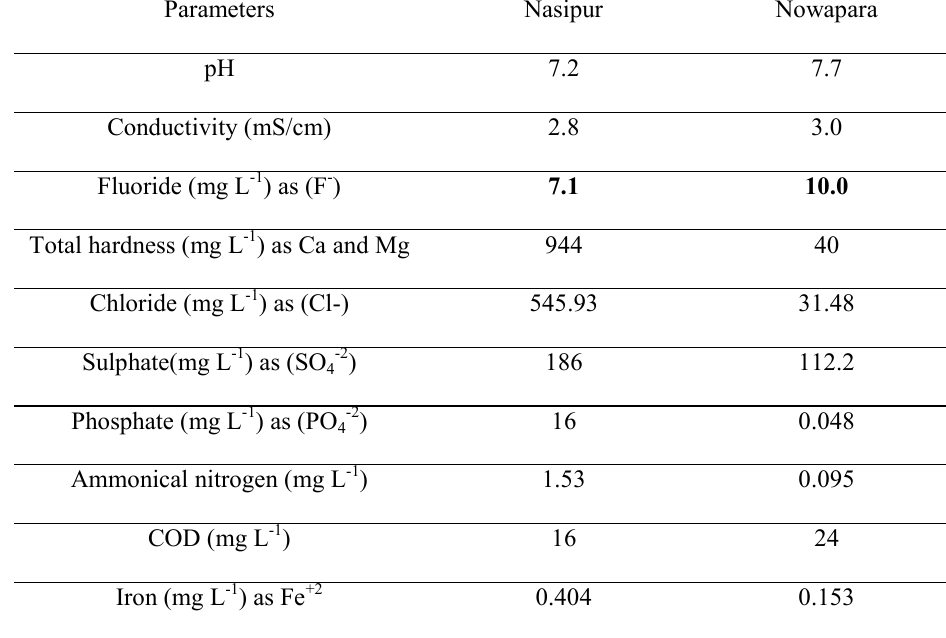
Table 6. Physico-chemical analysis of groundwater samples collected from study area (Nasipur and